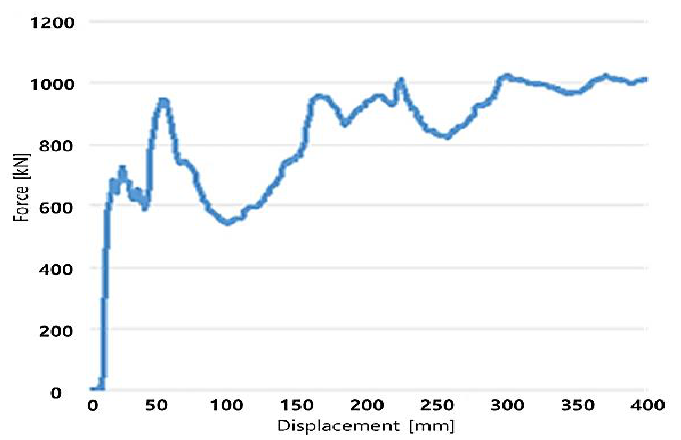
Figure 21. Body collapse characteristic curve.